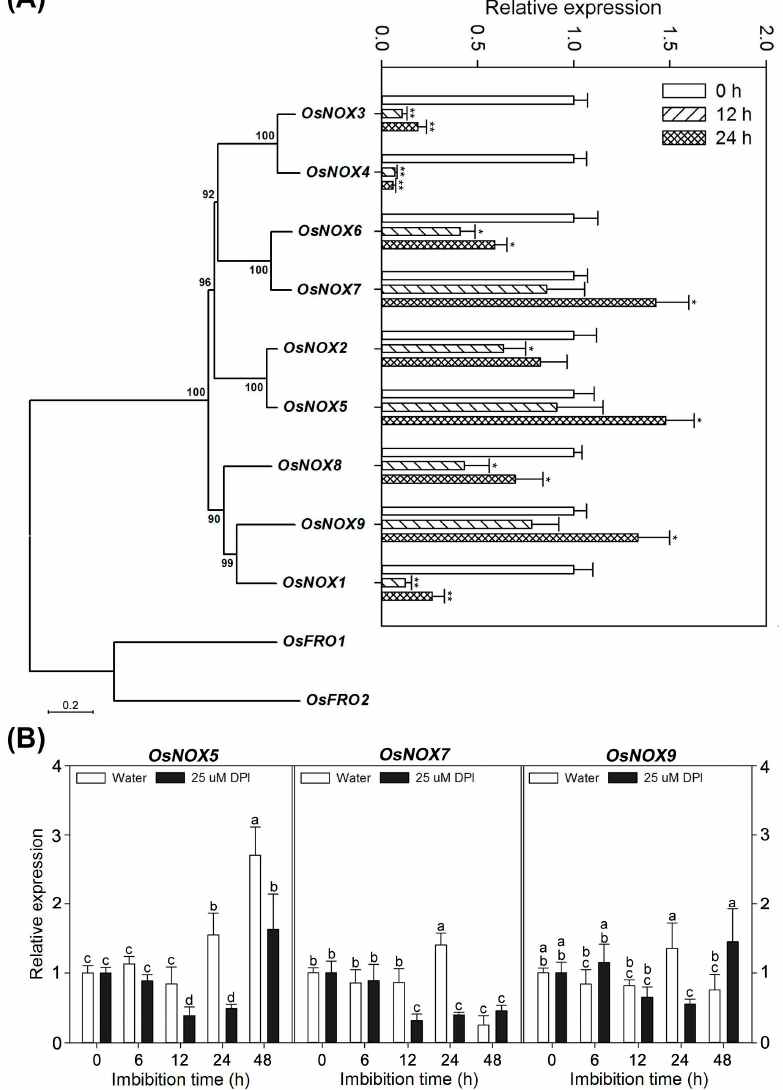
Figure 7. Expression profiles of the typical NOX genes OsNOX1–9 during germination of rice seeds. ( A ) Phylogenetic relationships of rice NOX family genes and expression profiles of the typical NOX genes ( OsNOX1–9 , [17]) in embryos assayed by qPCR after seeds had been incubated in water for 0, 12 and 24 h. Data represent the mean ± SE of three biological replicates of 30 embryos (~0.1 g). Significant differences for the qPCR data at 12 and 24 h from those at 0 h were assessed by the Student’s t -test (* p < 0.05; ** p < 0.01); ( B ) Expression of OsNOX5 , 7 and 9 in the embryo assayed by qPCR after seed imbibition in water or with 25 μ M DPI for 0, 6, 12, 24 or 48 h. Data represent the mean ± SE of three biological replicates of 30 embryos (~0.1 g). Means denoted by the same letter do not significantly differ at p < 0.05 (Fisher’s least significant difference test).